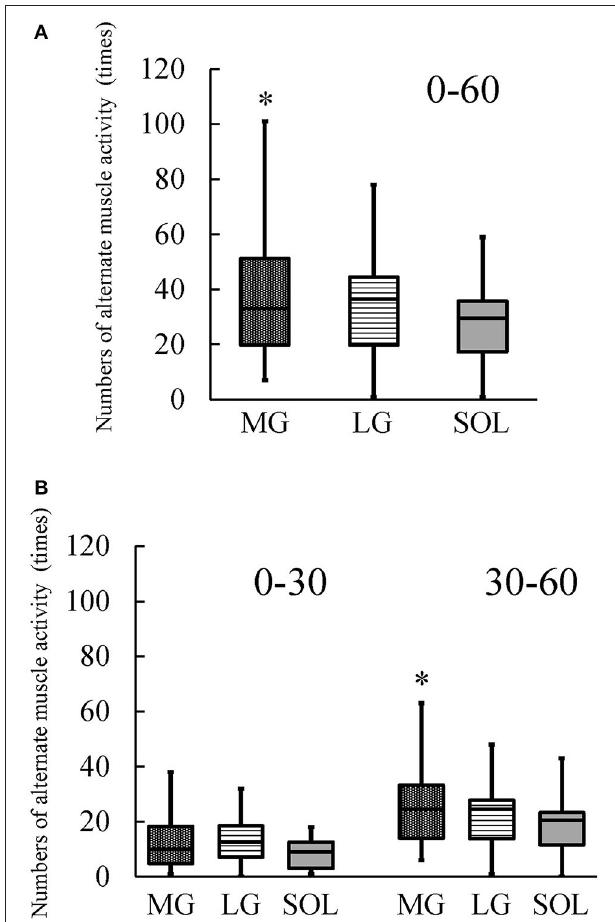
FIGURE 8 | Numbers of alternate muscle activity of the medial and lateral gastrocnemius muscles (MG and LG) and the soleus muscle (SOL) during the 1-h fatiguing task (0–60) (A) and every 30 min (0–30 and 30–60) ( n = 16) (B) . A boxplot shows median, 25th and 75th percentiles, and minimum and maximum values. The Friedman test revealed that there was a significant main effect of muscle. *Indicates the significantly higher numbers of alternate muscle activity of MG than of SOL ( P <